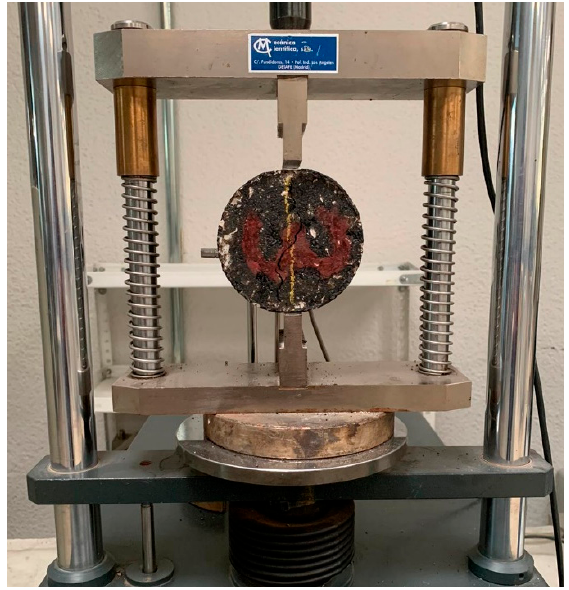
Figure 3. Indirect Tensile Strength (ITS) test.